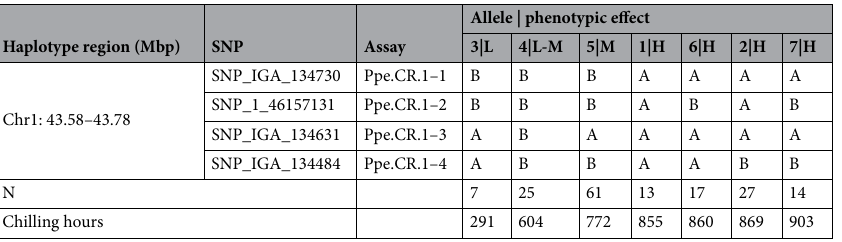
Table 2. Ppe.CR.1 allele information and their associated phenotypes determined in 86 accessions from Demirel et al. 35 . The number of individuals (N) with the presence of allele, and mean phenotype effect (chilling hours) for each allele are indicated. Chr chromosome, L low, M moderate, H high chill requirement.